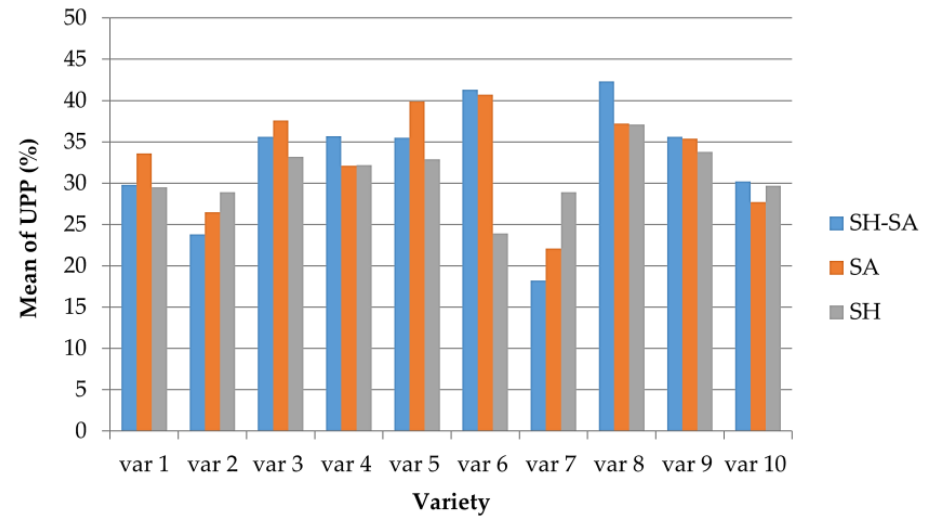
Figure 6. Mean of UPP (%) by variety and environment. SH-SA: suhumid-semiarid, SA: semiarid, and SH: subhumid.